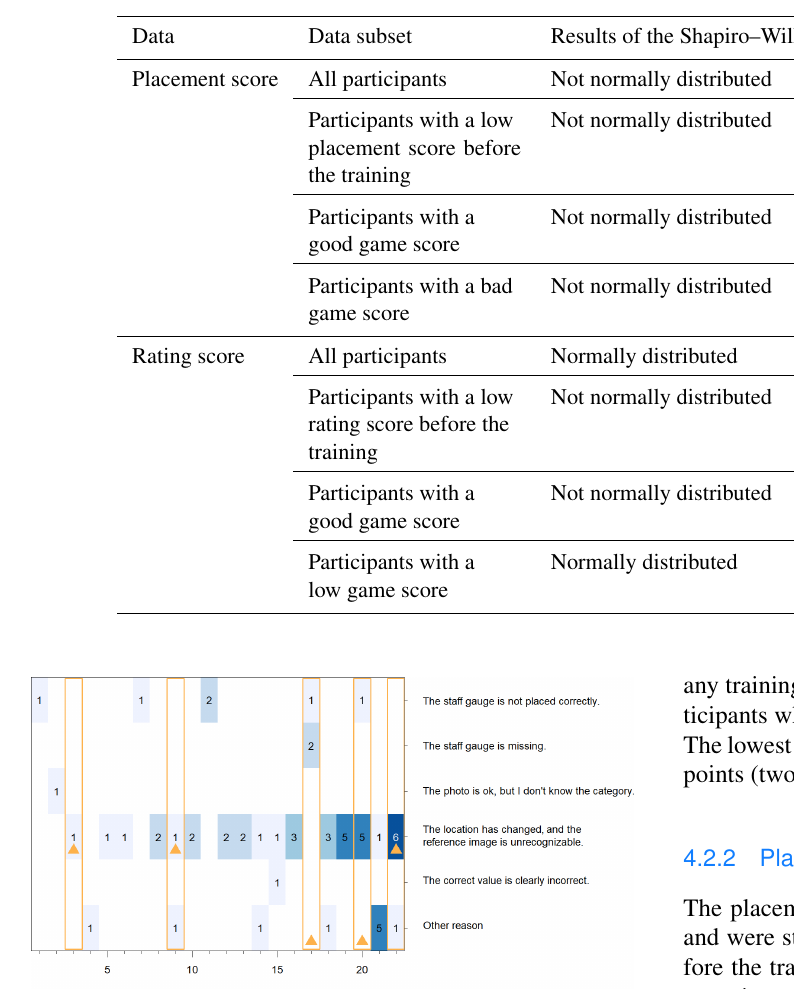
Table 1. The statistical tests were chosen based on whether or not the data were normally distributed according to the Shapiro–Wilk test. The tests for the placement score compared scores from before and after the training, as well as after the training and outdoors with the app. The test for the rating score compared scores from before and after training.